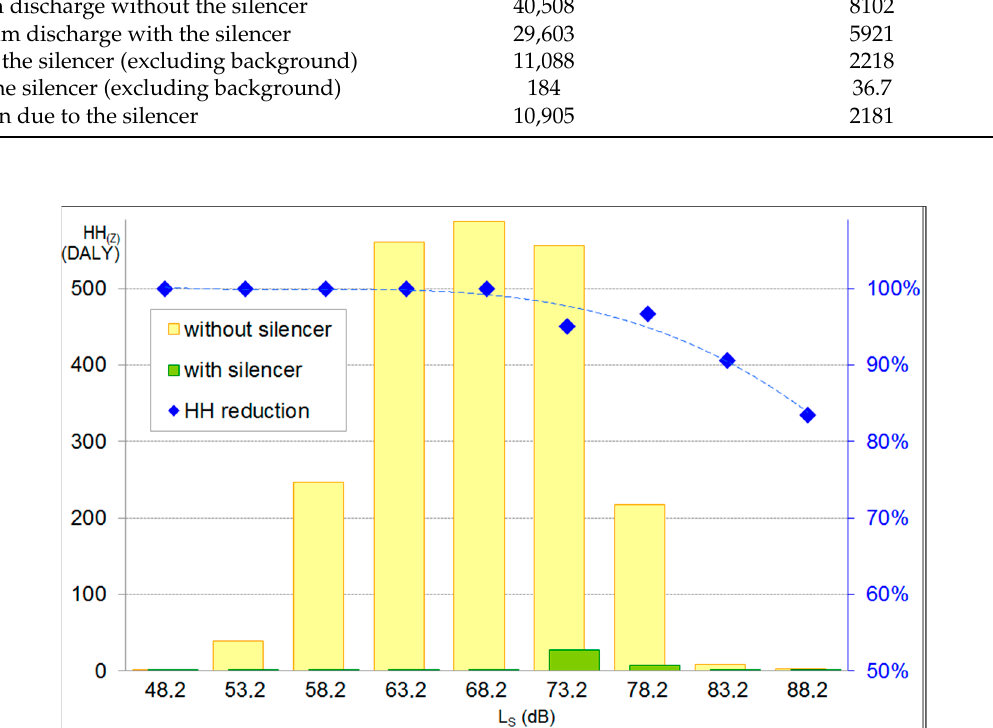
Figure 6. The distribution of the HH indicator over various L S noise